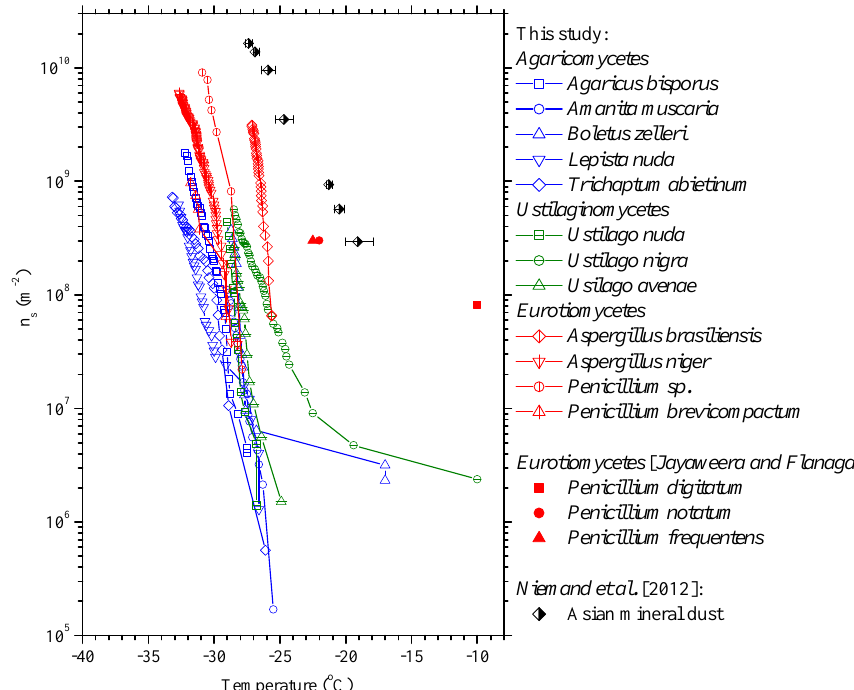
Figure 4. Ice nucleation active surface site density, n s (m − 2 ), for fungal spores determined using the data in Fig. 3. Agaricomycetes spores ( A. bisporus , A. muscaria , B. zelleri , L. nuda , and T. abietinum ) are in blue (open symbols); Ustilaginomycetes spores ( U. nuda , U. nigra , and U. avenae ) are in green (open symbols with a horizontal line); and Eurotiomycetes spores ( A. brasiliensis , A. niger , Penicillium sp., and P. brevicompactum ) are in red (open symbols with a vertical line). Also shown are n s values for Eurotiomycetes spores studied by Jayaweera and Flanagan (1982) (filled symbols), as well as for Asian mineral dust studied by Niemand et al. (2012) (half-filled